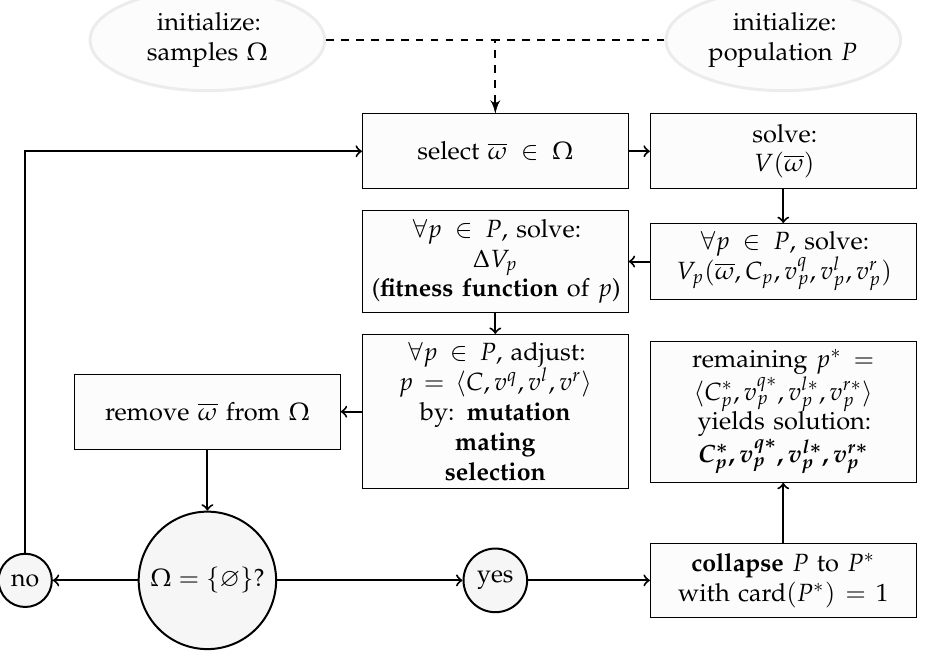
Figure 2. Genetic algorithm